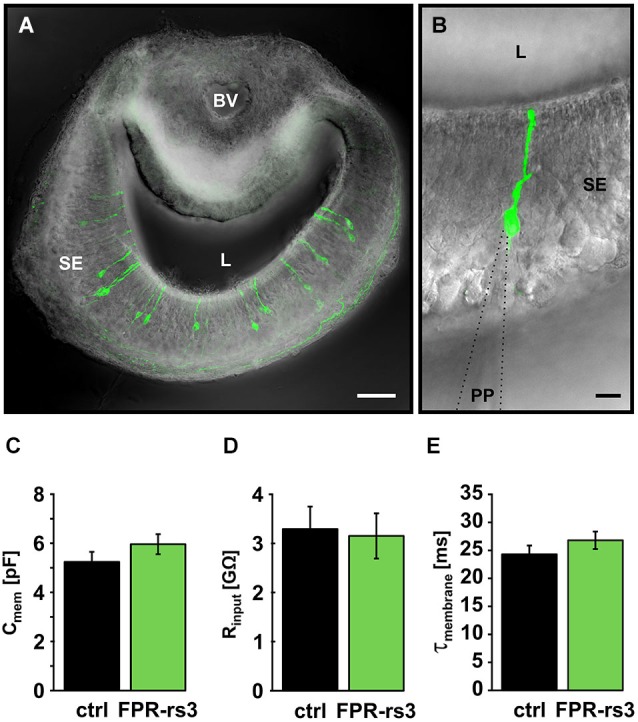
Passive membrane properties of FPR-rs3+ VSNs. (A) Confocal image (maximum projection) of a 150 µm acute coronal VNO tissue slice showing the distribution of fluorescent FPR-rs3 tau-Venus+ neurons (green) in the vomeronasal sensory epithelium. Fluorescent axon bundles are visible within the basal lamina. (B) FPR-rs3 tau-Venus+ neurons exhibit a single apical dendrite ending in a knob-like structure at the luminal border. Whole cell patch-clamp recordings were performed from the VSN soma. (C) Membrane capacitance and (D) input resistance (Rinput) are similar for both control and FPR-rs3+ neurons (n = 21). (E) Membrane time constant (τmembrane) of control neurons compared to FPR-rs3+ cells shows no significant difference (n = 21). Data are mean ± SEM. Blood vessel (BV), lumen (L), patch pipette (PP), sensory epithelium (SE). Scale bars, 50 µm (A), 10 µm (B).